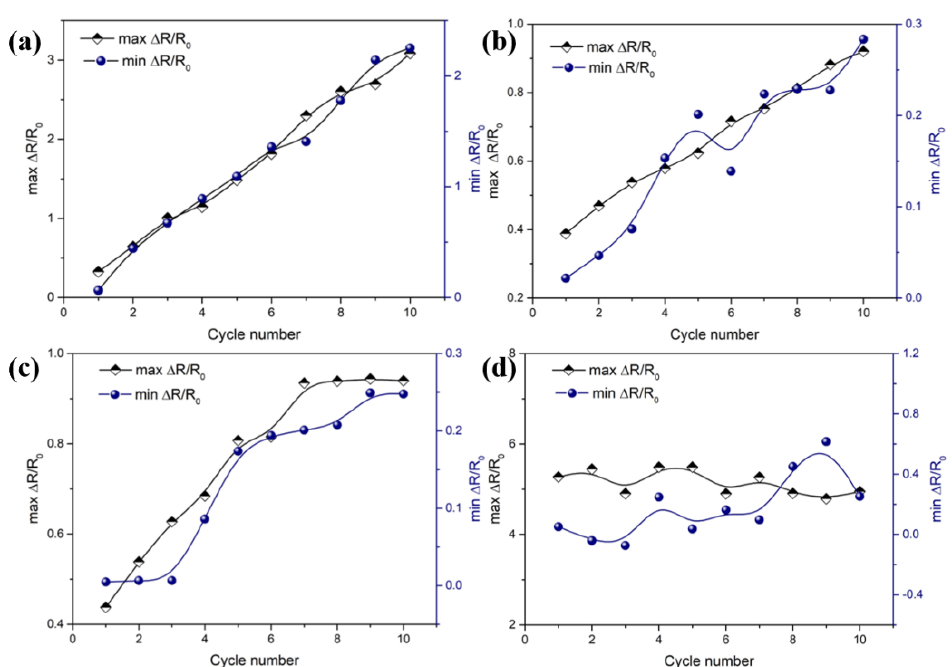
Figure 8. The variations of max ΔR/R 0 and min ΔR/R 0 with cycle number for CB/PA6/PP composites: ( a ) λ = 1, ( b ) λ = 5, ( c ) λ = 10, ( d ) λ = 15 in ten times extension – retraction cycles.